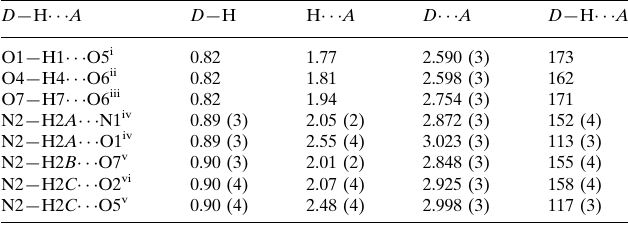
Hydrogen-bond geometry (A˚ , (cid:2)